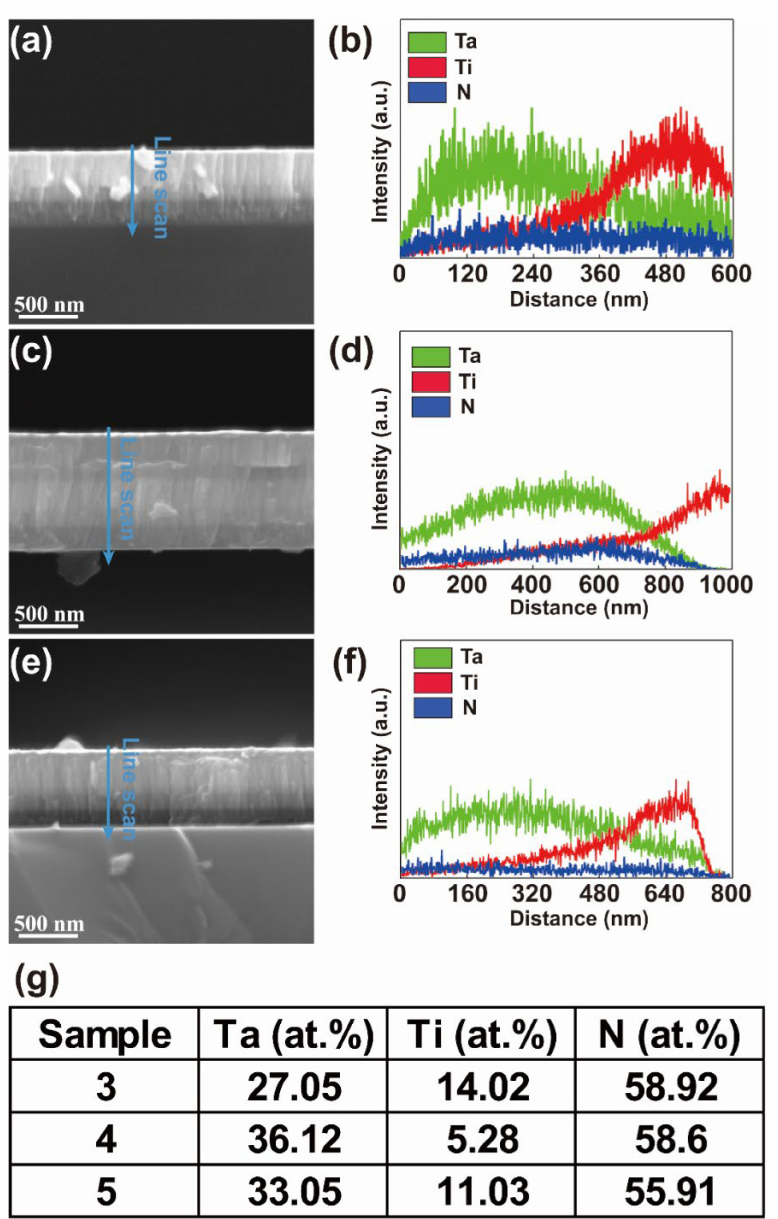
Figure 3. Cross-sectional SEM images of ( a ) Sample 3, ( c ) Sample 4, and ( e ) Sample 5. Energy- dispersive spectroscopy (EDS) line analysis results of ( b ) Sample 3, ( d ) Sample 4, and ( f ) Sample 5. ( g ) Atomic percentages of Samples 3, 4, and